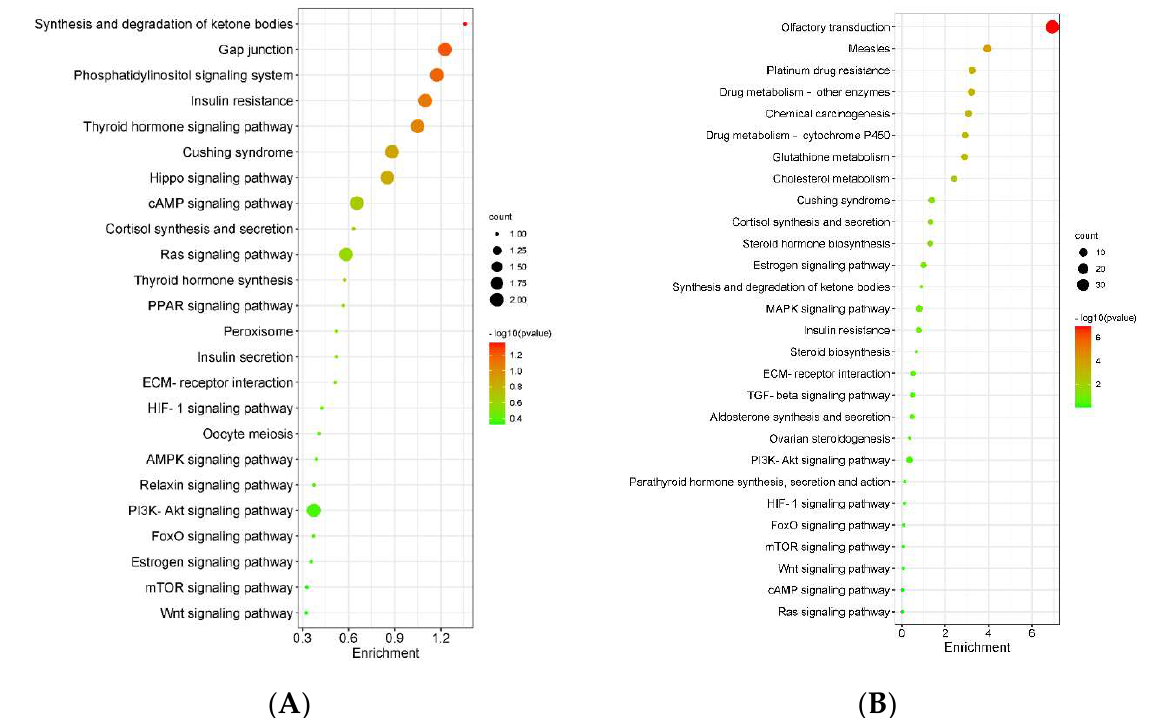
Figure 3. The KEGG analysis for candidate genes related to reproductive traits and significant pathways in the twin colt group. ( A ) F ST and θπ; ( B ) θπ and Tajima’s D. Table 1. Genes associated with reproductive traits in twin colt group revealed by F ST and θπ.